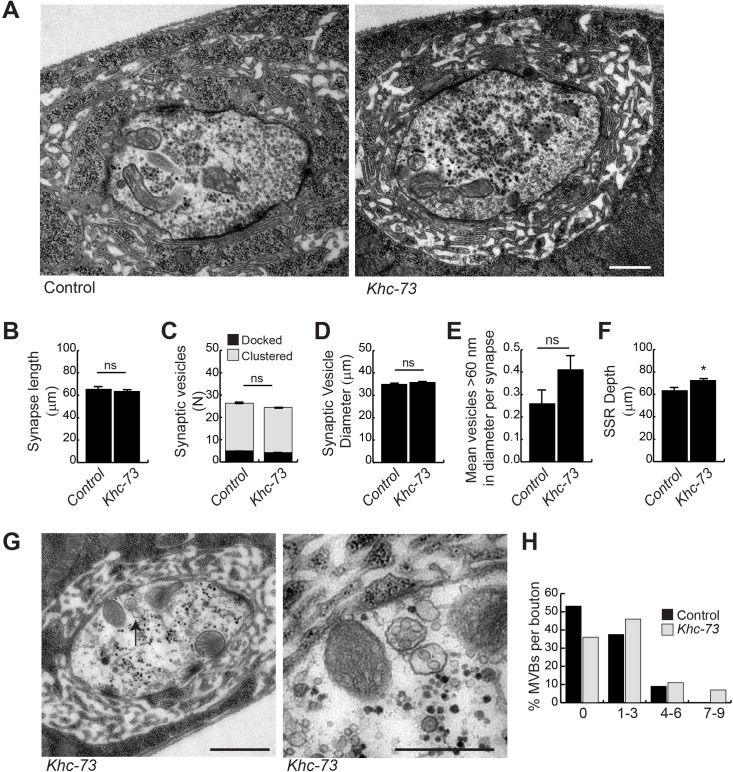
EM analysis of Khc-73 mutant larvae.(A) EM micrographs of Control (Khc-73100) and Khc-73 (Khc-73193). Magnification 25000x. Scale bar is 0.5 μm. (B) Quantification of synapse length in Control (Khc-73100) and Khc-73 (Khc-73193). N = 79, 153 synapses. (C) Quantification of docked and clustered synaptic vesicles at each synapse for Control (Khc-73100) and Khc-73 (Khc-73193). N = 79, 153 synapses. (D) Quantification of synaptic vesicle diameter for Control (Khc-73100) and Khc-73 (Khc-73193). N = 2082, 3750 synaptic vesicles. (E) Mean number of vesicles >60nm in diameter at the synapse. N = 79, 153 synapses. (F) Quantification of subsynaptic reticulum (SSR) depth at the synapse. N = 79, 153 synapses. (G) EM micrographs of multivesicular bodies in Khc-73 mutant. Magnification of MVB denoted by arrow in left panel (right panel). Scale bar 1 μm. (H) Proportion of boutons with indicated number of multivesicular bodies for control (Khc-73100) and Khc-73 (Khc-73193). N = 33, 28 boutons. Error bars are S.E.M. Student’s t-test. *P<0.05, ns-no statistical significance.